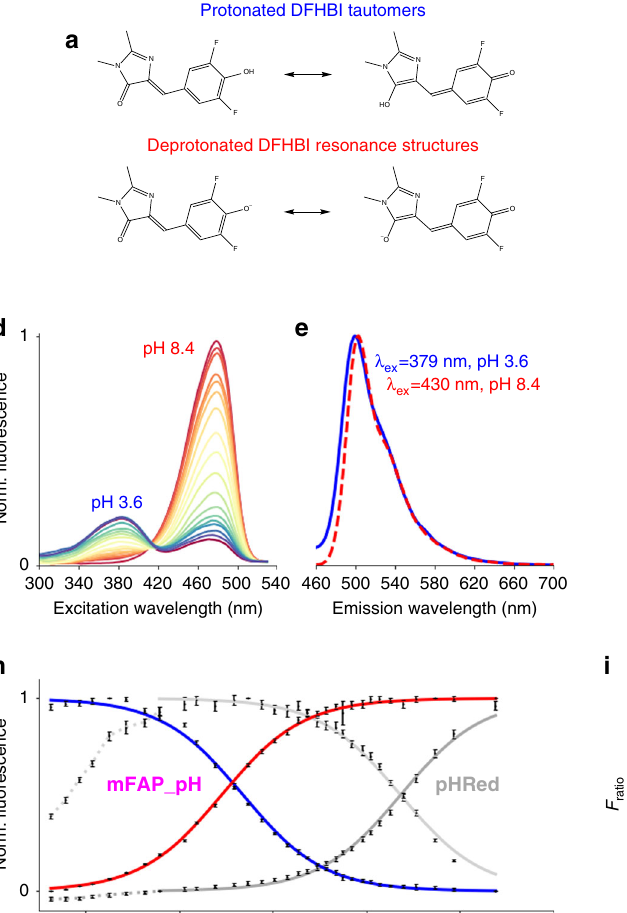
Table 2). Ca 2 + transients in the SR during cardiac contraction cycling were detectable with high photostability (Supplementary